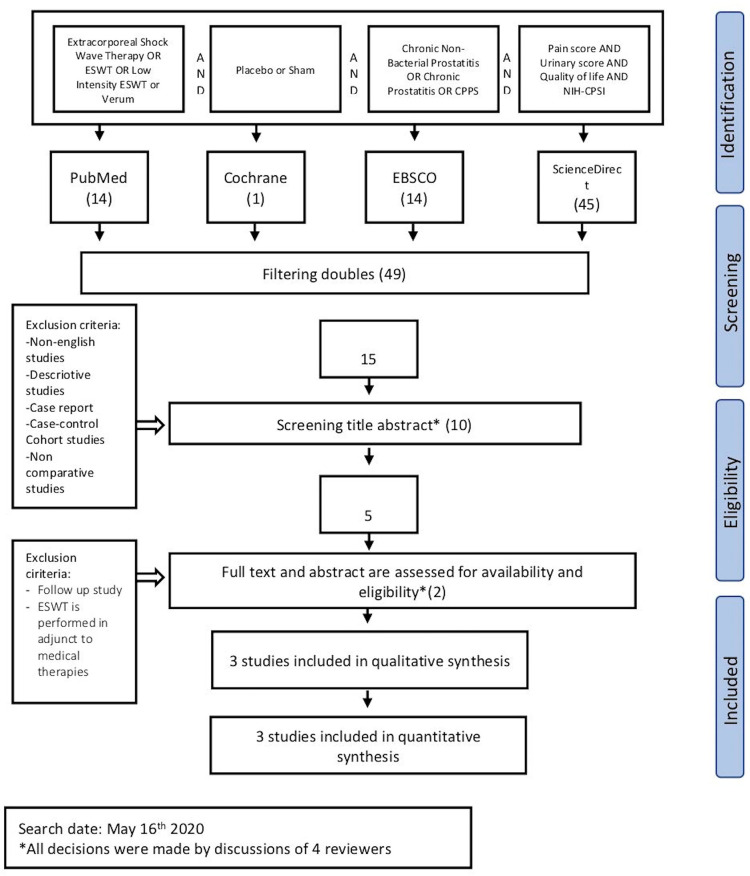
Study flow diagram.